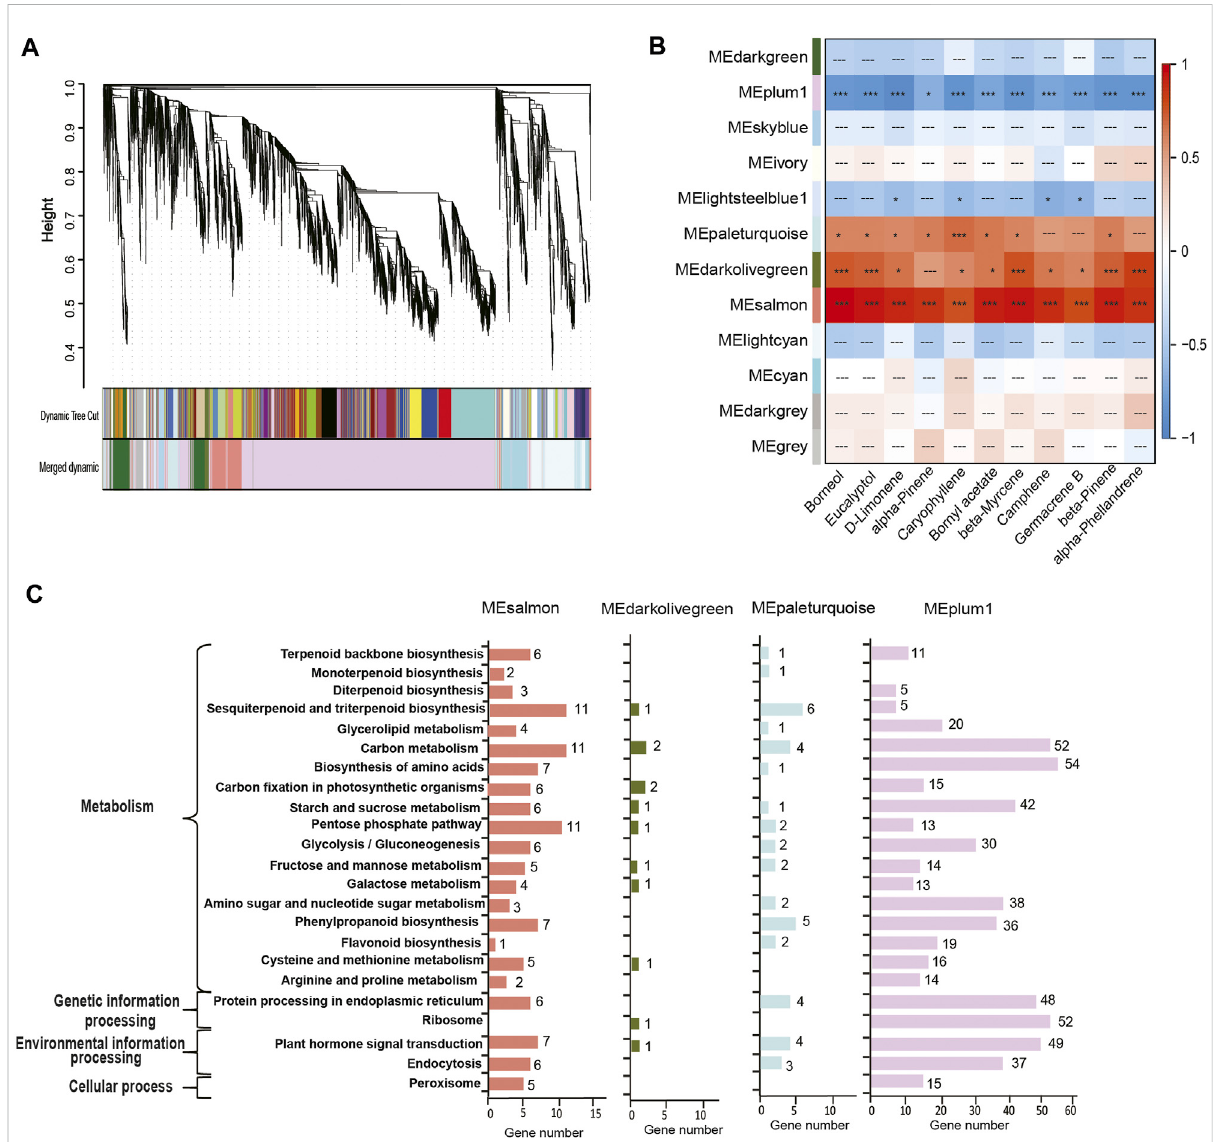
FIGURE 4 Weighted correlation network analysis of genes across four developmental stages in C. burmannii . (A) Hierarchical clustering of co-expressed genesshowstheco-expressionmodules.Eachbranchinthephylogenetictreecorrespondstoanindividualgene,andtheinterconnectedgenesare grouped intotwelvemodules. (B) Heatmapbasedongeneexpressionpatternsshowsthemodule-metaboliterelationships.Thecolorbarshowsthe correlation between the twelve modules and the top 11 monoterpenes and sesquiterpenes; blocks were colored in red and blue indicate positiveandnegativecorrelations.Symbols “ *** “ , ” * ” ,and “ --- ” representhighlysigni fi cant(Fisher ’ sexacttest; p < 0.01),signi fi cant( p < 0.05),andnon- signi fi cant ( p ≥ 0.05) correlations. (C) KEGG pathway analysis of the DEGs of the four modules signi fi cantly associated with the